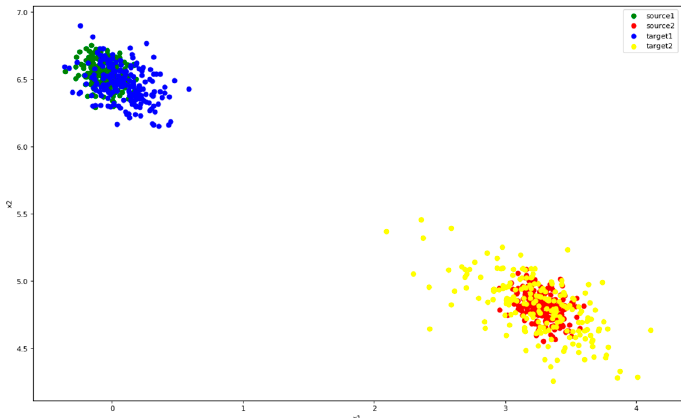
Figure 14. Distribution of features after CMMD. Color green represents class 1 of source and red represents class 2. Blue is the class 1 of target and yellow the class 2.